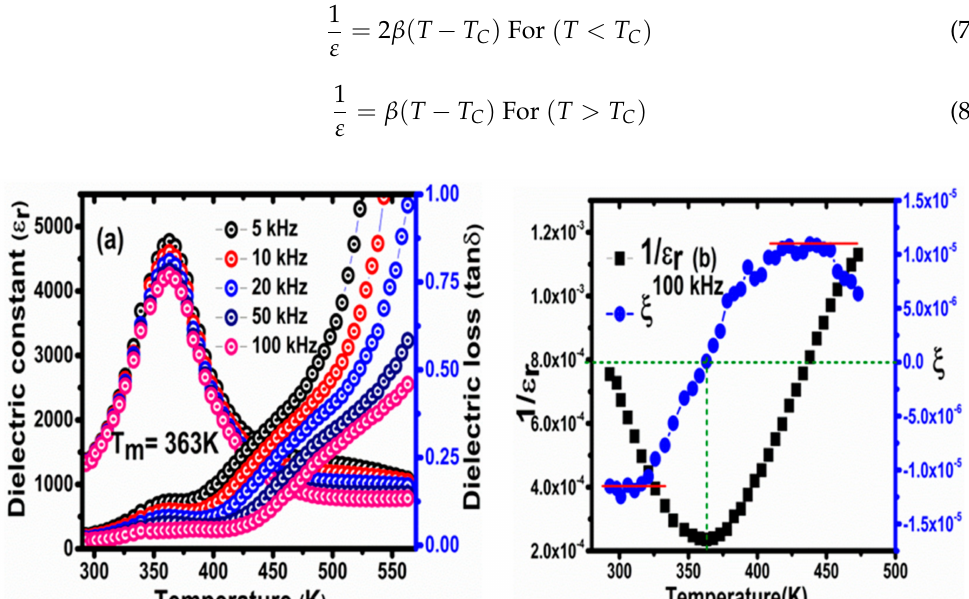
Figure 4. ( a ) Dielectric constant vs. temperature ( ε r ) and dielectric loss (tan δ ) vs. temperature plot of PC10 for some selected frequencies. ( b ) Temperature dependence reciprocal of the dielectric constant ) and its temperature derivative ( ξ ) at 100 ( 1 ε